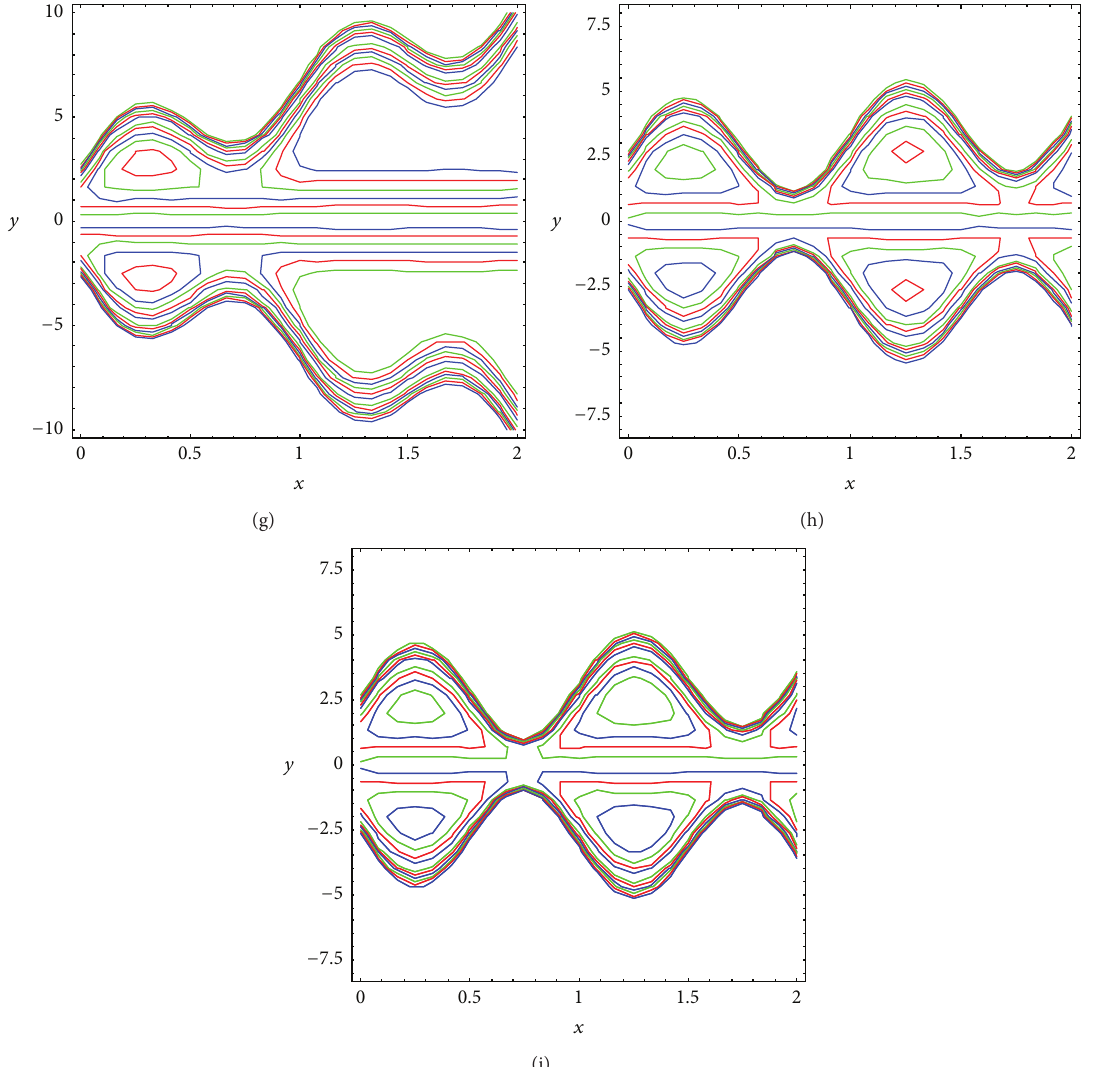
Figure 5: Streamlines in wave frame at 𝜙 = 0 . 3, 𝑞 = 0 . 6 for (a) 𝛽 = 0, 𝑛 = 1, 𝛼 = 𝜋/ 6, 𝛿 = 1, (b) 𝛽 = 0 . 1, 𝑛 = 1, 𝛼 = 𝜋/ 6, 𝛿 = 1, (c) 𝛽 = 0 . 2, 𝑛 = 1, 𝛼 = 𝜋/ 6, 𝛿 = 1, (d) 𝛽 = 0, 𝑛 = 0 . 8, 𝛼 = 𝜋/ 6, 𝛿 = 1, (e) 𝛽 = 0, 𝑛 = 1 . 2, 𝛼 = 𝜋/ 6, 𝛿 = 1, (f) 𝛽 = 0, 𝑛 = 1, 𝛼 = 𝜋/ 4, 𝛿 = 1, (g) 𝛽 = 0, 𝑛 = 1, 𝛼 = 𝜋/ 3, 𝛿 = 1, (h) 𝛽 = 0, 𝑛 = 1, 𝛼 = 𝜋/ 6, 𝛿 = 2, and (i) 𝛽 = 0, 𝑛 = 1, 𝛼 = 𝜋/ 6, 𝛿 =